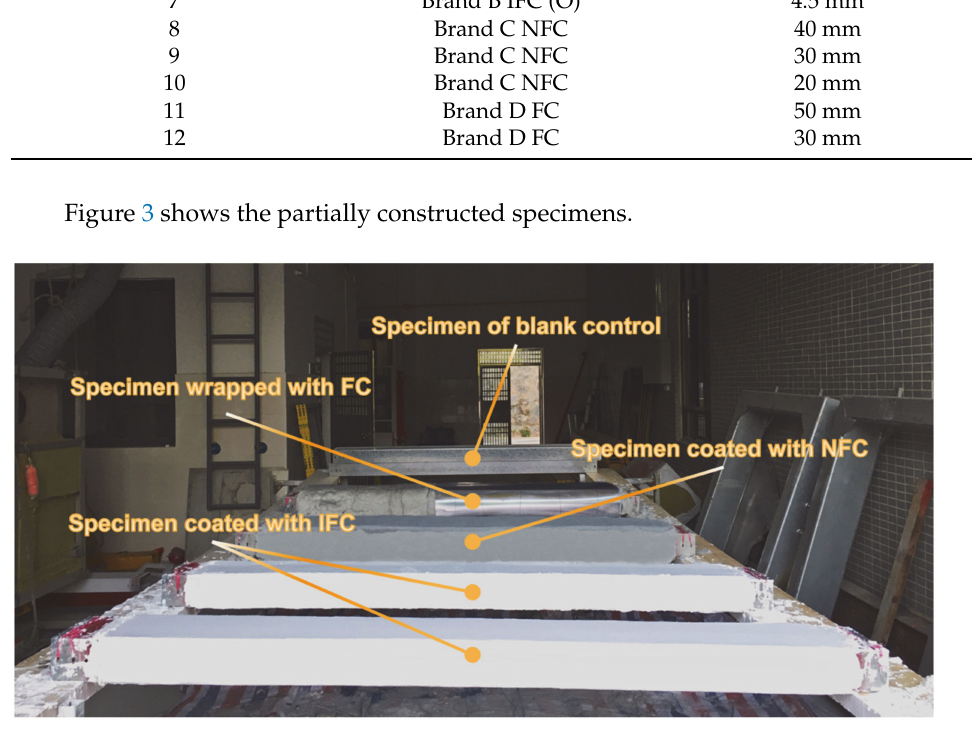
Figure 3. Construction of completed specimens.